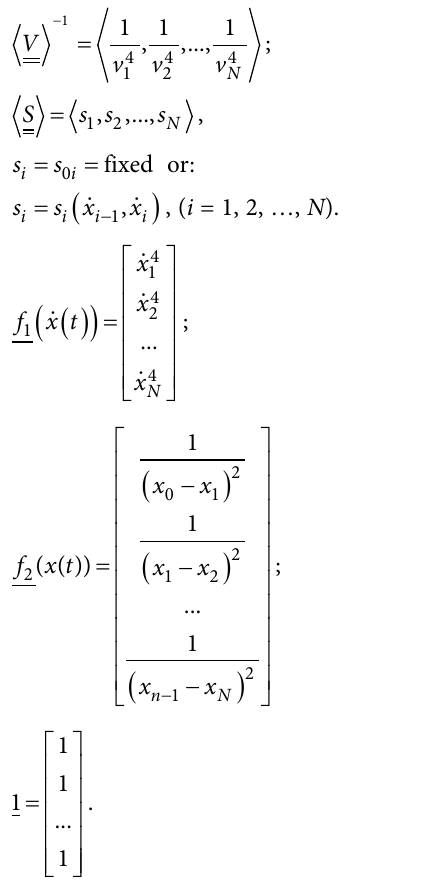
Open Gl library